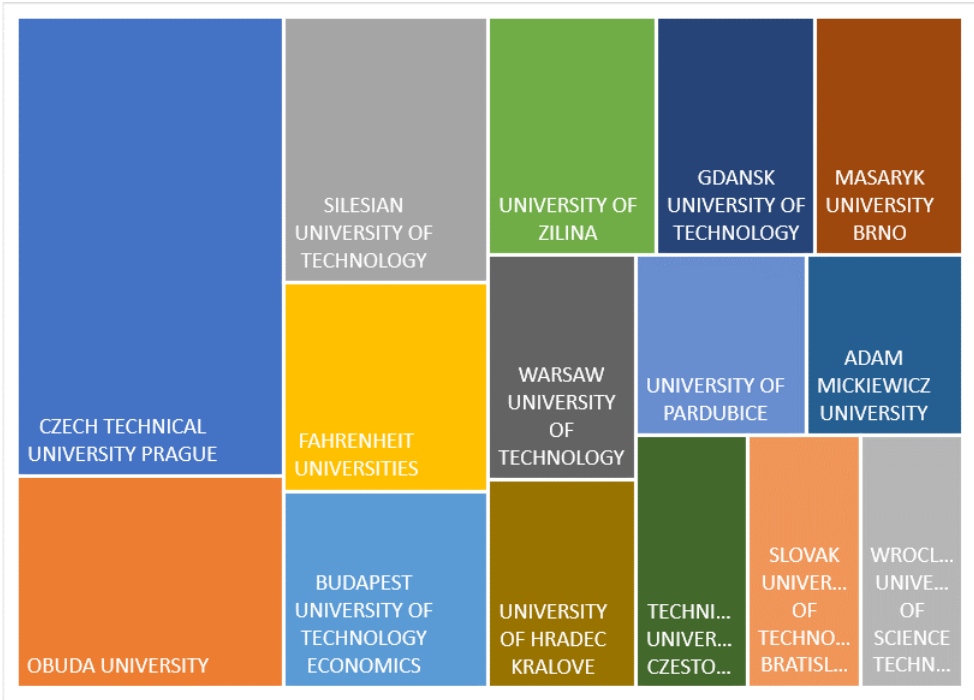
Figure 16. An overview of the V4 universities that publish the most on the topic of Smart cities. Source: own analysis as per Web of Science (2022).